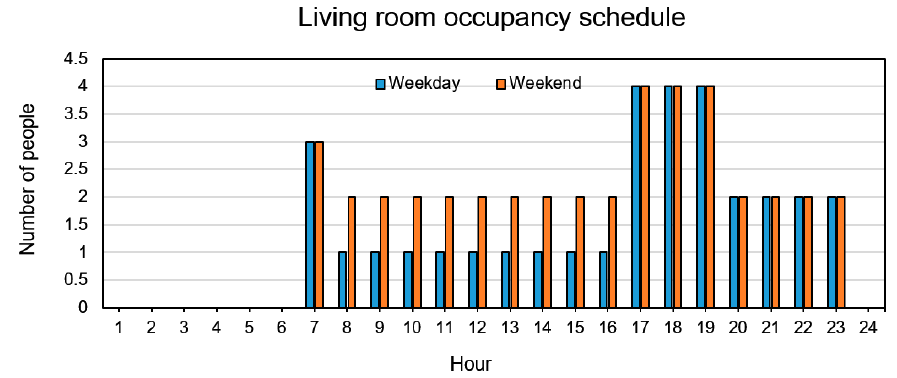
Figure 25. Living room occupancy schedule.